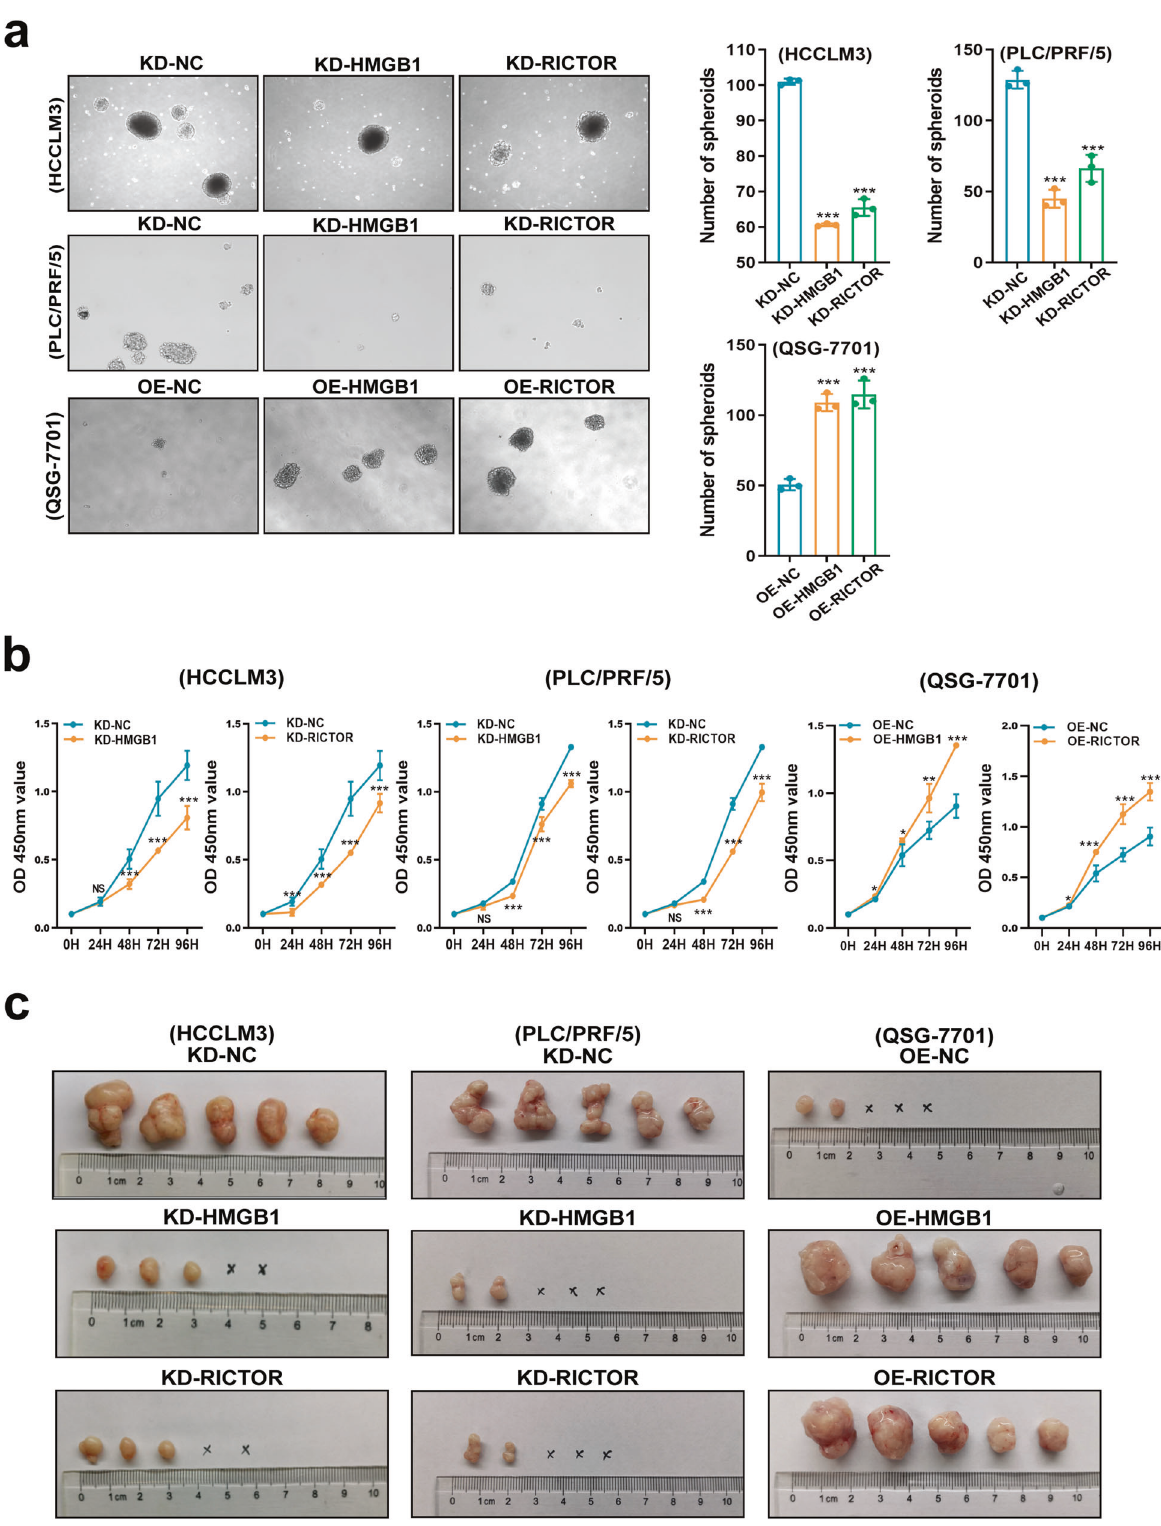
Fig. 4 HMGB1 epigenetically promotes stem-like properties in HCC cells. a Determination of spheroid formation after 3000 cells were seeded in low-adhesion plates for 10 days (left). The number of tumor spheroids was quantitated (right). *** p < 0.001. b Cell proliferation was evaluated using CCK8 assays. The results are means ± SEM. * p < 0.05, ** p < 0.01, *** p < 0.001. c Male nude mice ( n = 5) were subcutaneously injected with 1 × 10 4 HMGB1/RICTOR 3 ′ UTR over-expressed liver cells (abbreviated as “ OE-HMGB1 or OE-RICTOR ” , respectively) or HMGB1/ RICTOR mRNA interference HCC cells (abbreviated as “ KD-HMGB1 or KD-RICTOR ” , respectively). Tumorigenesis was assessed after 48 days as